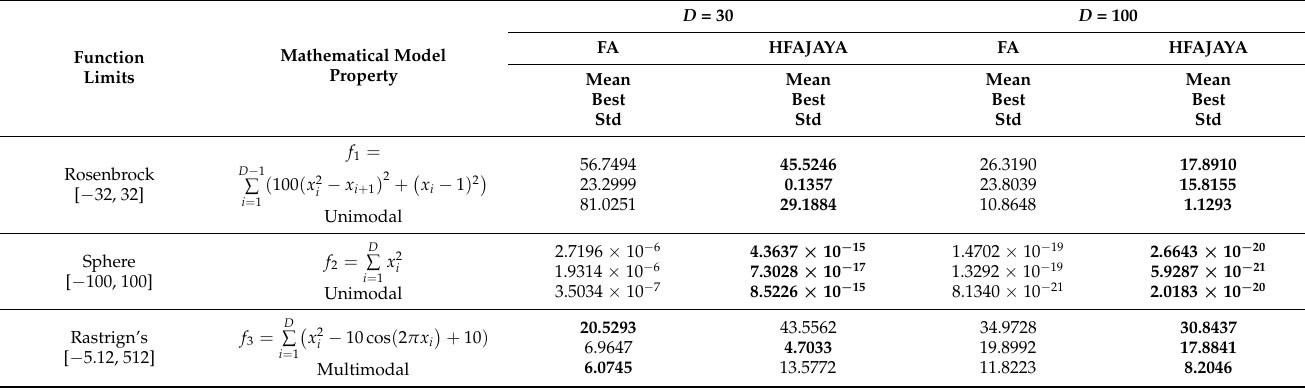
Table 1. Optimization results for three selected popular functions by the